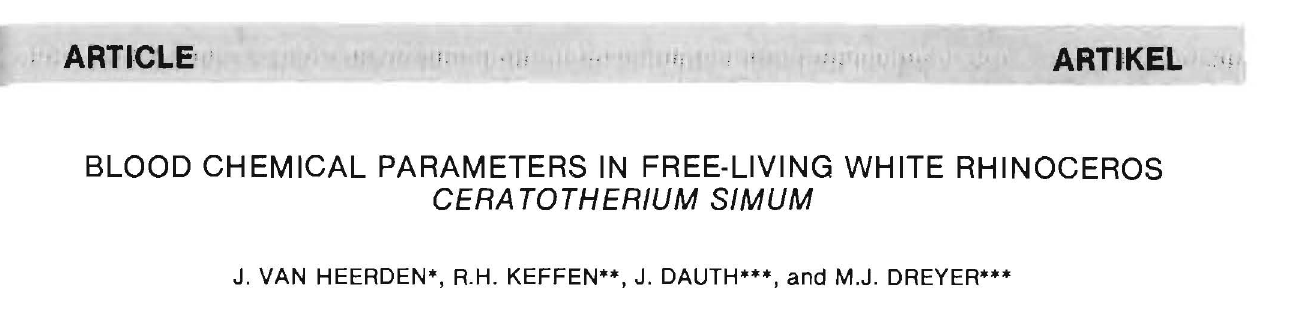
Fig. 1: Densitometric scan of serum proteins of the rhinoceros